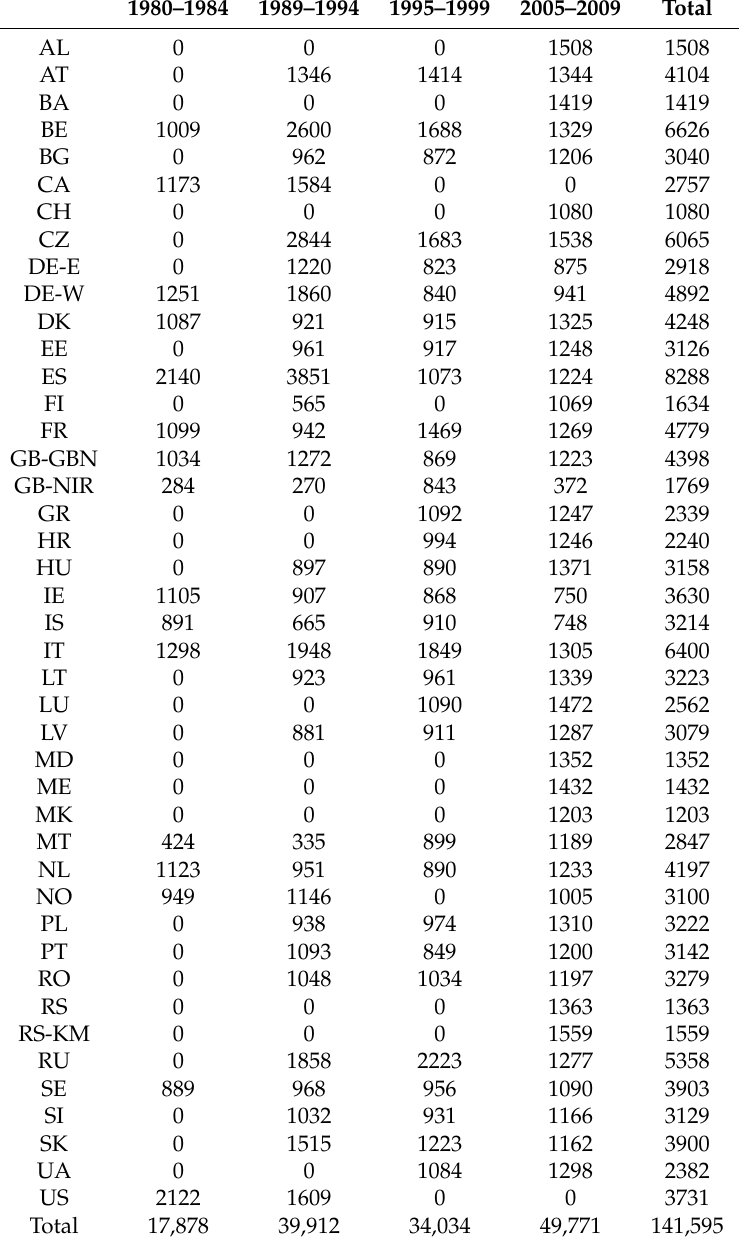
Table A10. The number of observations for the importance of having a job that is useful for society by country and